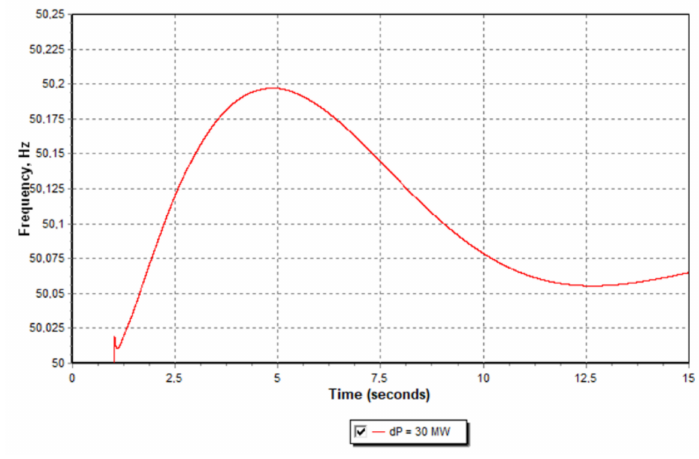
Figure 9. Frequency change in the isolated power system caused by a load decrease (case B).